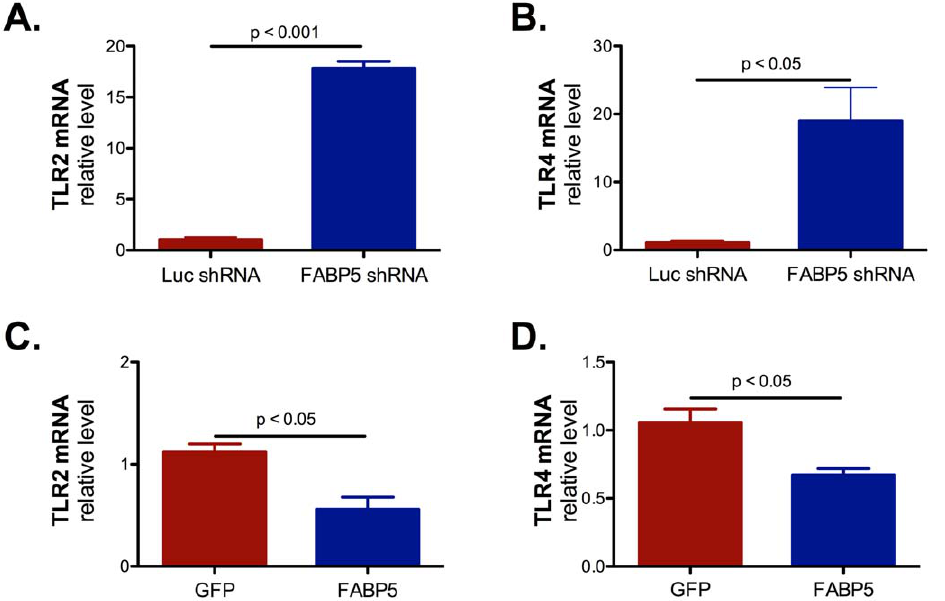
Figure 6. FABP5 expression modulates TLR2 and TLR4 mRNA expression. A. TLR2 mRNA expression was induced in cells knocked down for FABP5. B. TLR4 mRNA expression was induced in cells knocked down for FABP5. C. TLR2 mRNA expression was decreased in cells overexpressing FABP5. D. TLR2 mRNA expression was decreased in cells overexpressing FABP5. Data are representative of 3 independent experiments and are expressed as mean 6 SEM.